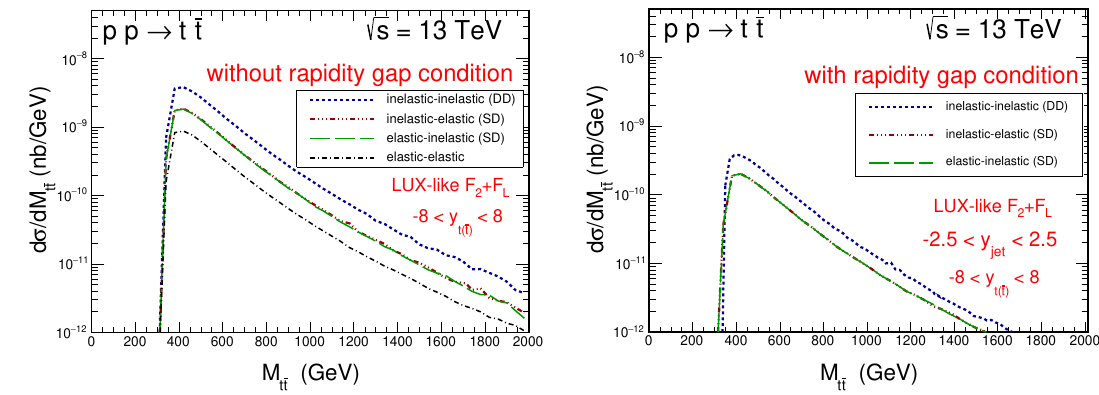
Figure 4 . t (cid:22) t invariant mass distribution for di(cid:11)erent components de(cid:12)ned in the (cid:12)gure. The left panel is without imposing the condition on the struck quark/antiquark and the right panel includes the condition.